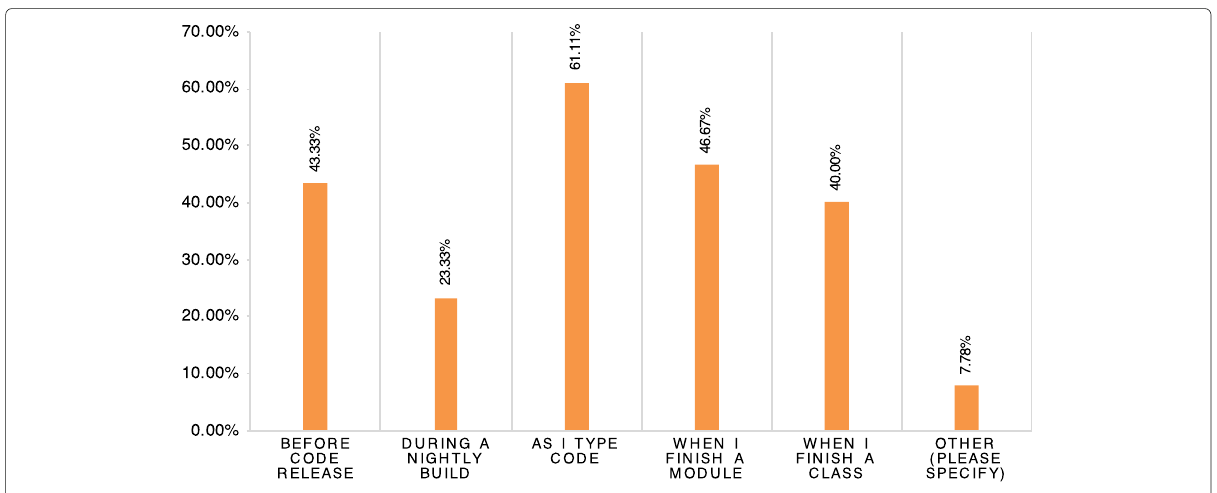
Fig. 6 Situations under which programmers would use the proposed plugin